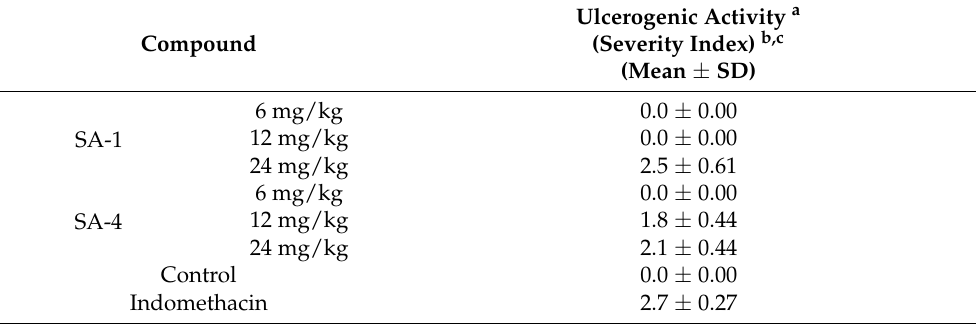
Table 5. In vivo ulcerogenic activity of the compounds in rat